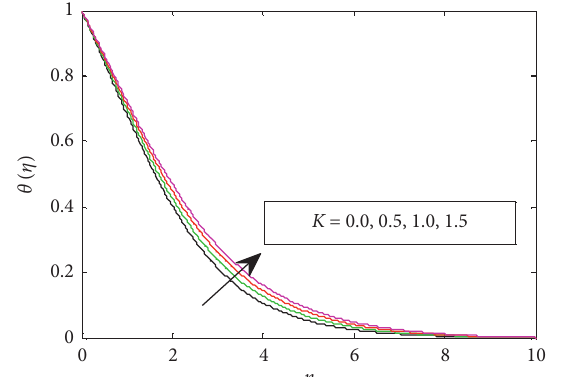
Figure 15: Angular velocity distribution for different values of mixed convection parameters.